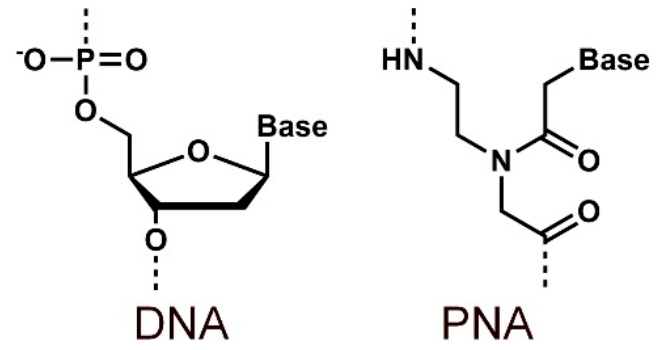
Figure 1. Structures of DNA and PNA.